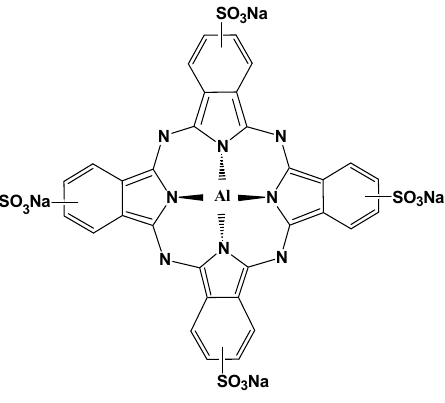
Figure 1. Molecular structure of AlS 4 Pc.